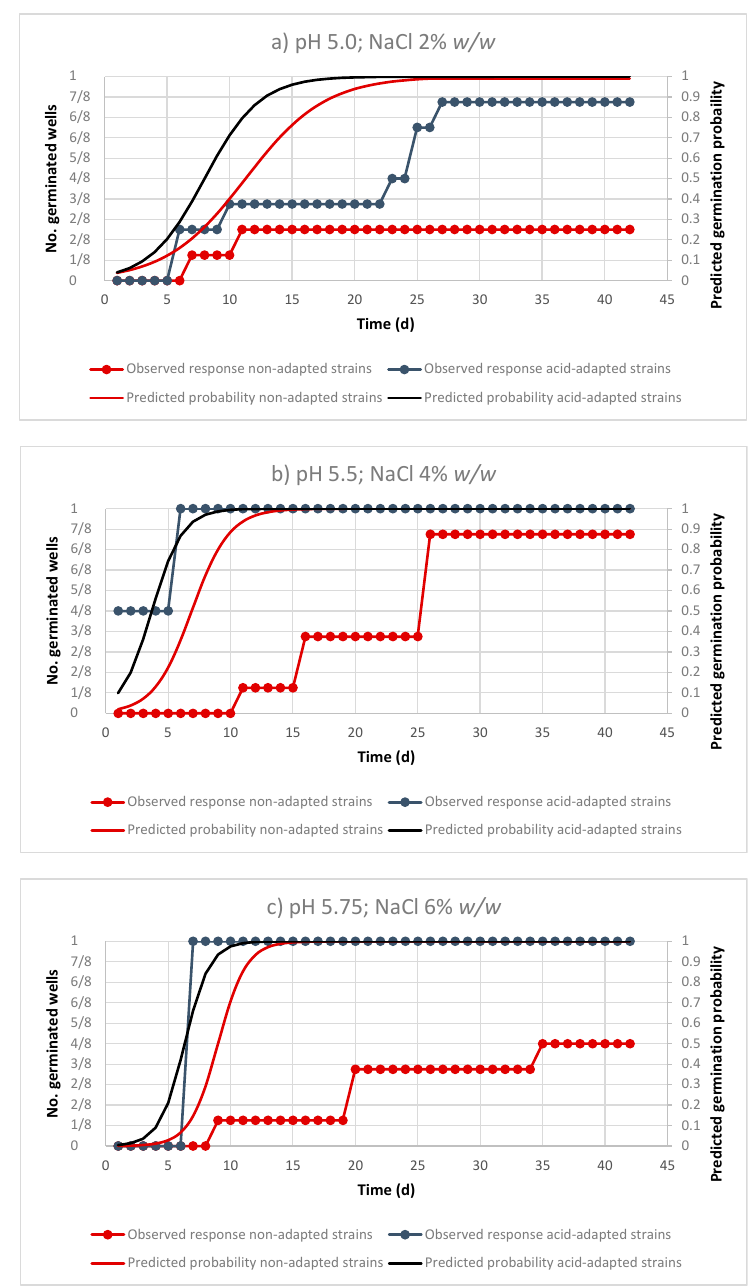
Figure 3. Evolution of predicted probabilities of germination and observed responses over experimental time for the non ‐ adapted and acid ‐ adapted strains of C. sporogenes at different combinations of pH and NaCl (panels a – c ).